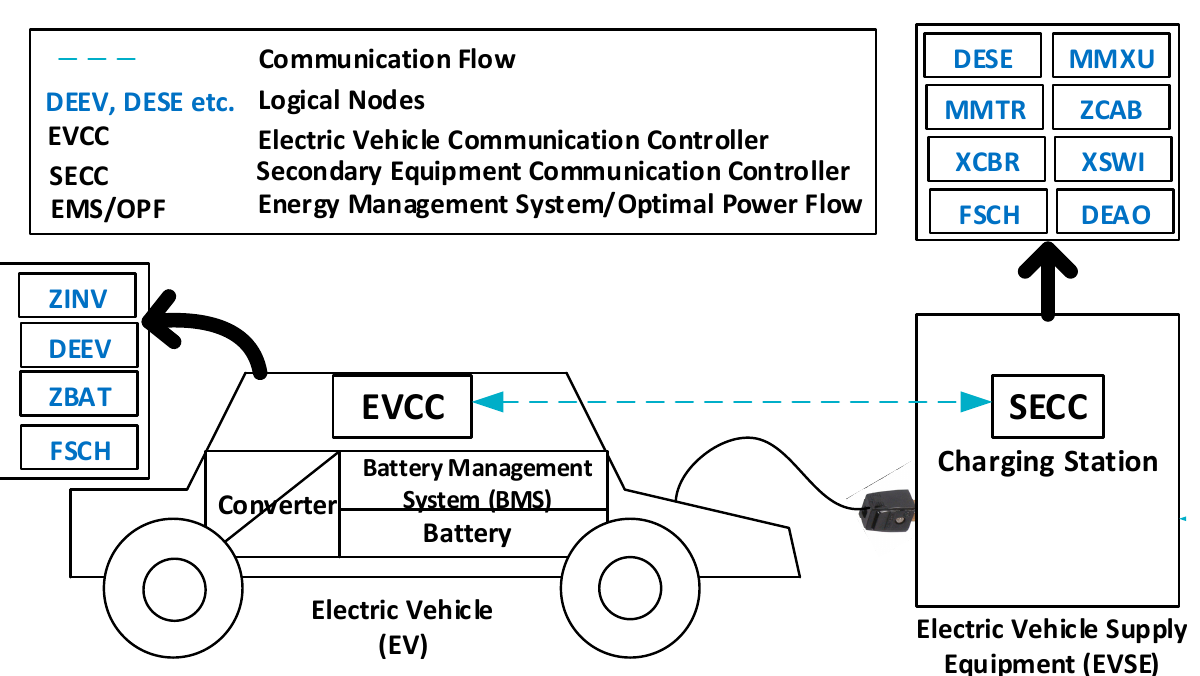
Figure 1. EV and CS information models.